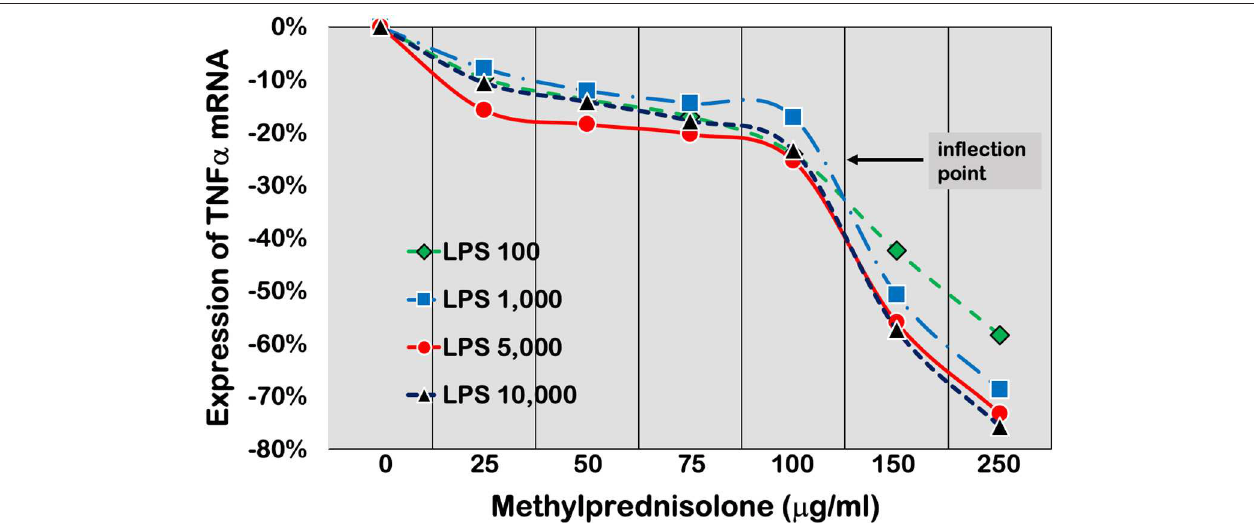
FIGURE 7 | Regression of concentration of methylprednisolone on steady-state mRNA levels of TNF- α in U937 cells primed with graded concentrations of lipopolysaccharide (LPS). In experimental simulation of severe inflammation, human monocytic cells (U937 cells) were activated with graded concentrations of LPS (100ng/ml, 1.0 µ g/ml, 5.0 µ g/ml, or 10.0 µ g/ml) for 6h followed by measurement of the expression of inflammatory cytokines [TNF- α (shown), IL-1 β , and IL-6]. Graded concentrations of LPS were followed by progressively higher inflammatory cytokine transcription (for TNF- α : 185, 318, 481, and 566, respectively). These cells were then exposed to graded concentrations of methylprednisolone [( µ g/ml): 50, 100, 150, 200, 250] for 6h followed by repeated measurement of inflammatory cytokine expression (see below). The steady state mRNA levels of TNF- α , IL-1 β , or IL-6 in LPS-activated cells were reduced by treatment with methylprednisolone in a concentration-dependent manner. The effective dose of methylprednisolone was 175mg, a value that appeared to be independent of the priming level of LPS and type of mRNA measured ( 102). Modified with permission from Meduri et al.